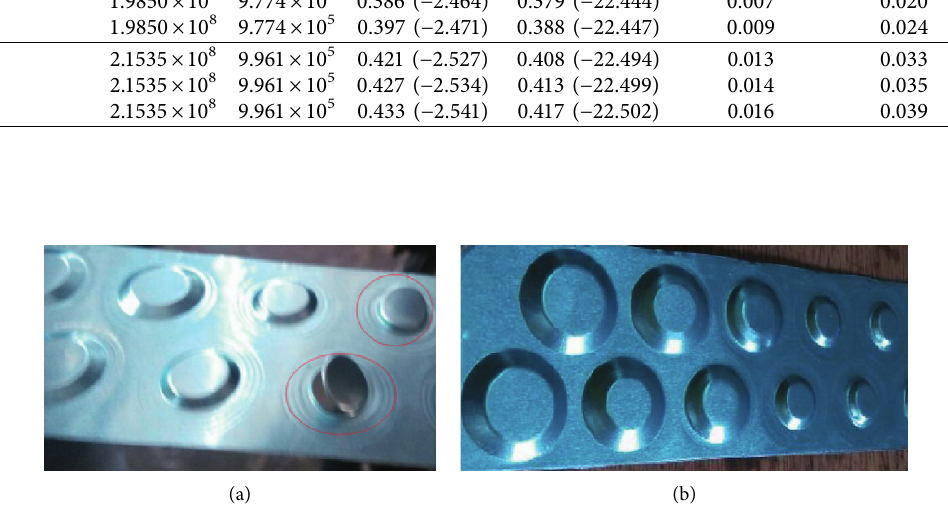
Figure 12: Comparison of drawing results before and after installation foundation with a size of 2.4m × 3.3 m × 1.6m: (a) experimental result without foundation; (b) experimental result with